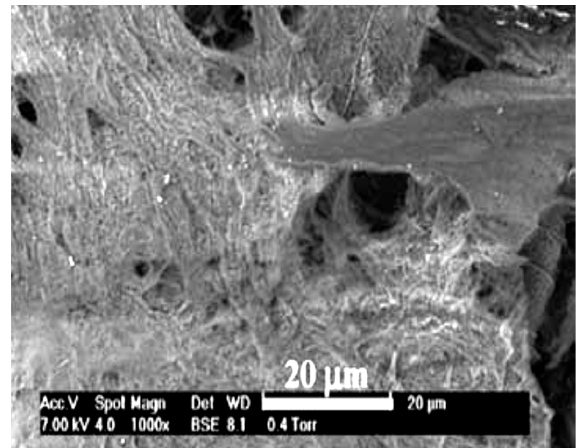
Figure 8. PCL/PLA nanofibrous scaffold cultured in 3T3 mouse fibroblasts cells for 4 weeks (reprinted from Ref. [34]).